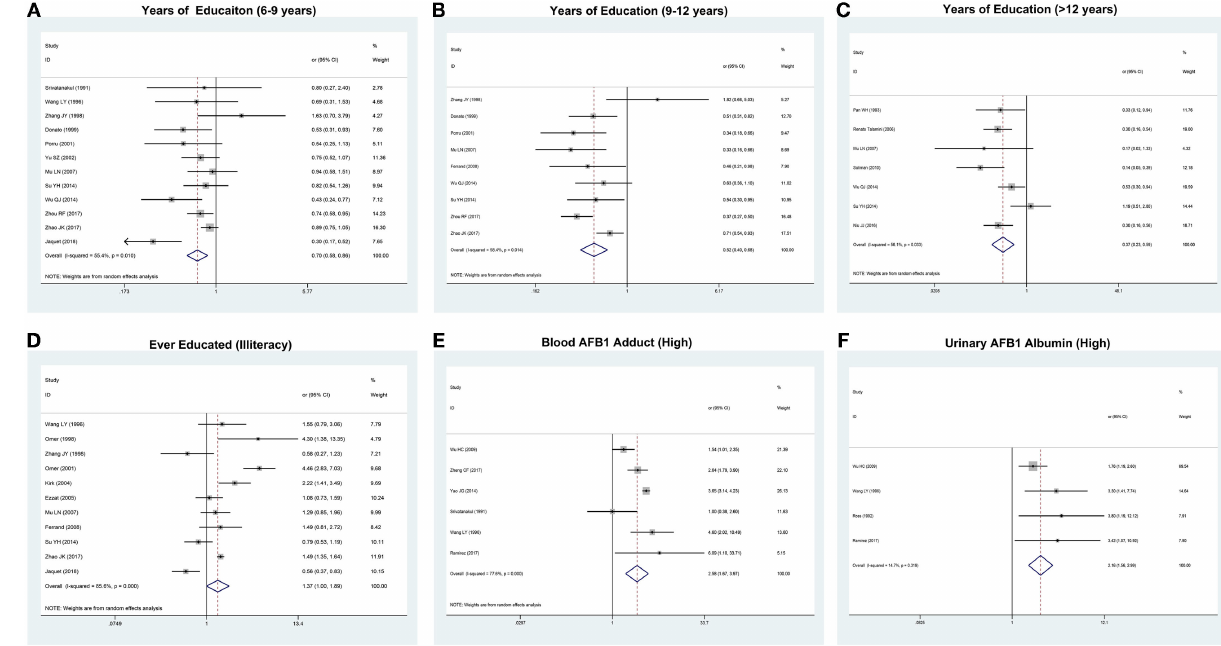
Frontiers in Public Health |